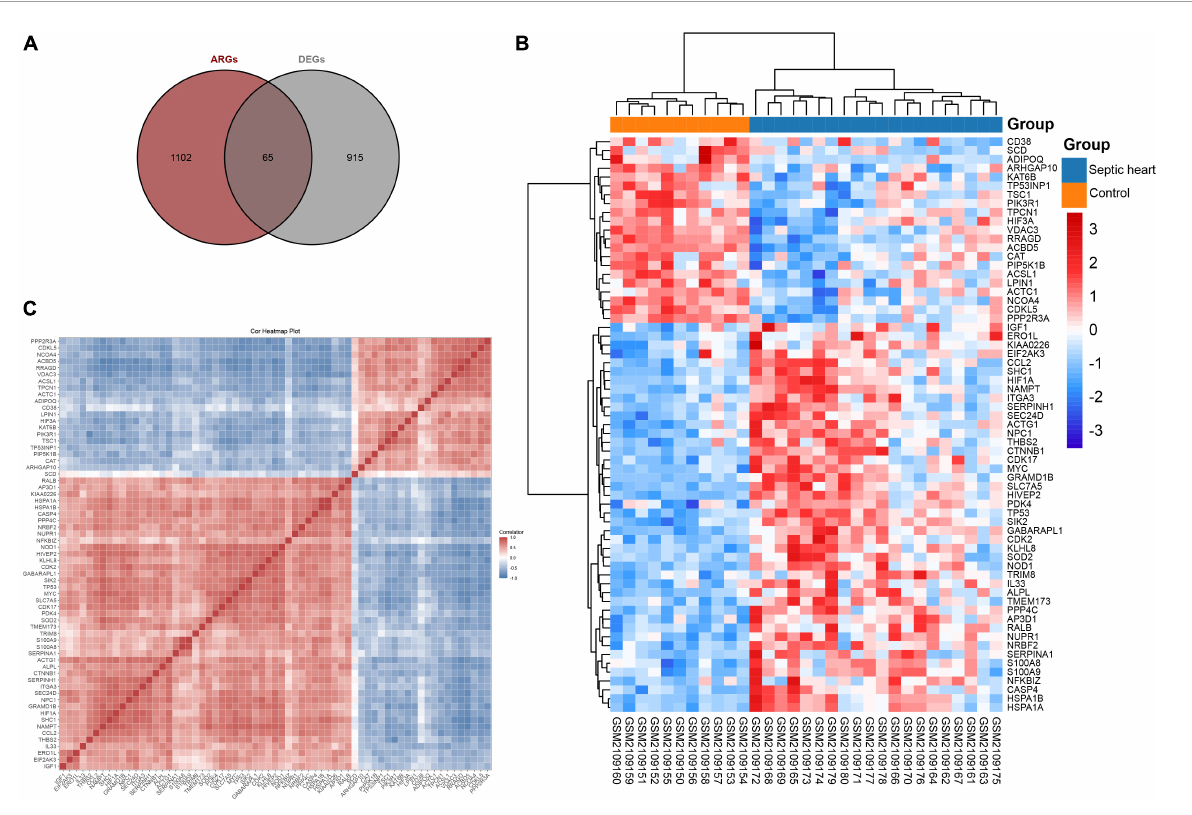
FIGURE3 Identification of differentially expressed ferroptosis-related genes. (A) Venn diagram showing the overlap of genes between DEGs in GSE79962 and ARGs in autophagy-related databases. (B) Clustered heatmap of DEARGs in GSE79962. (C) Correlation heatmap of DEARGs in GSE79962, correlation coefficients are plotted with negative correlation (blue) and positive correlation (red). DEG, differentially expressed gene; DEARG, differentially expressed autophagy-related